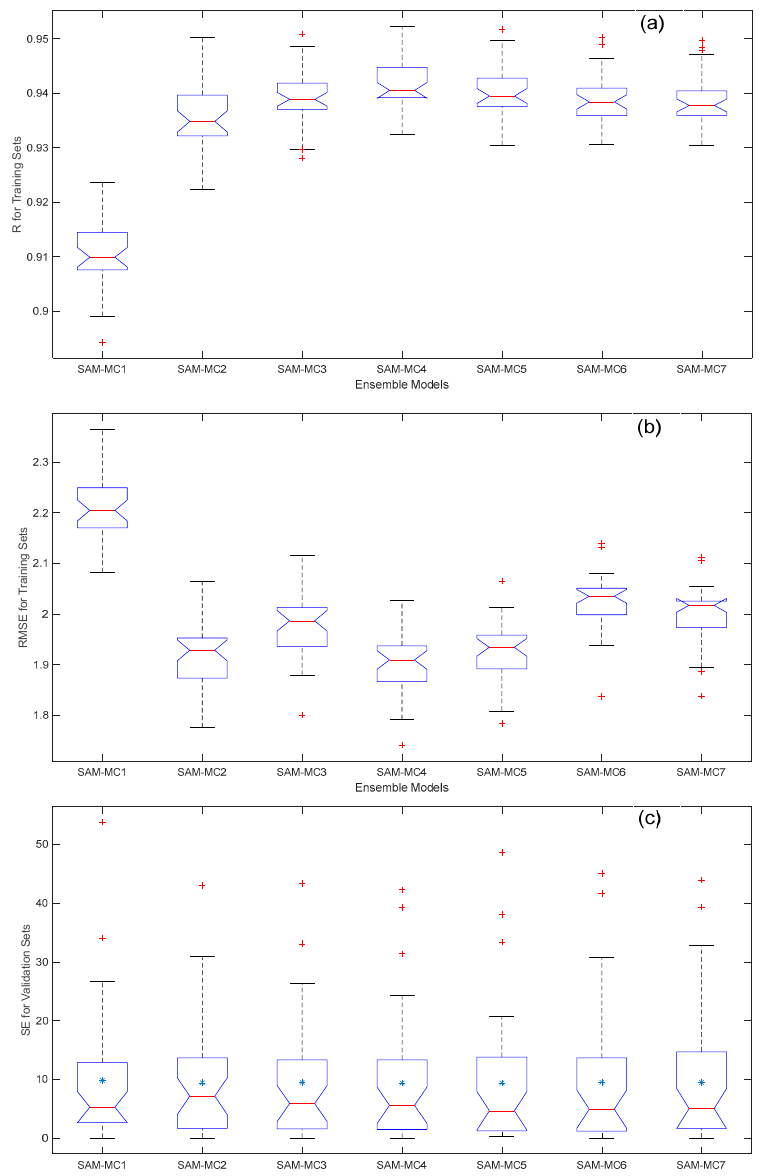
Figure 6. Performance of selected kNN-based stacking ensemble learning models using multiple-type distance functions. ( a ) R for training sets. ( b ) RMSE for training sets. ( c ) SE for validation sets.